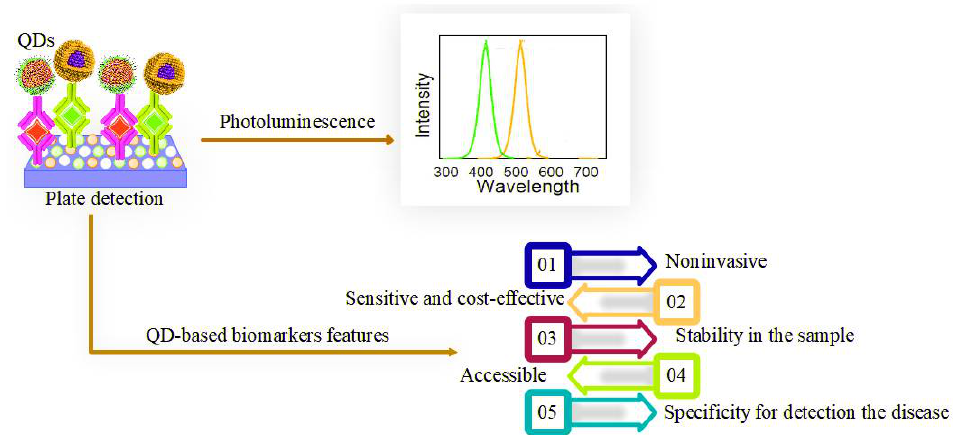
Figure 7. QD-based biomarker features for the detection of viral disease. Table 3. QD-based biomarkers that are made to detect biomarkers of infectious diseases. Infectious Disease